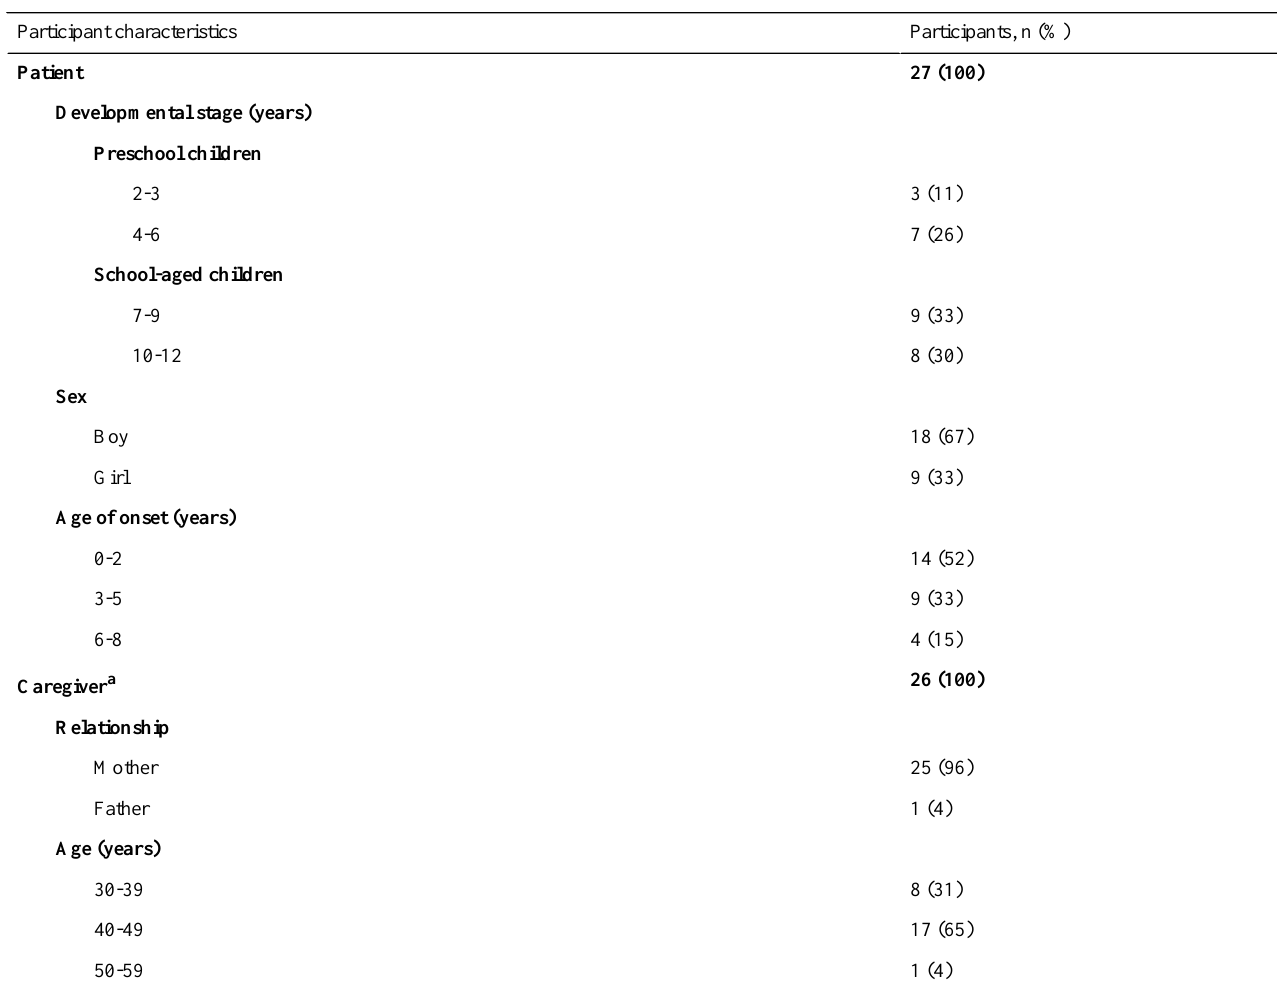
(Table 2). By grouping the categories, 4 themes (ie, confirmation of asthma knowledge, child–caregiver interaction, app design, and child’s interest) were